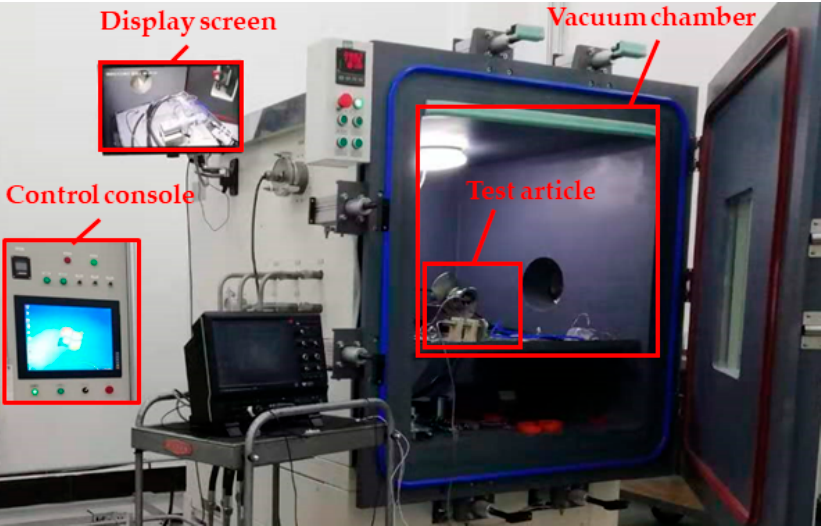
Figure 9. Test stand for opening and closing characteristics of vent valve.